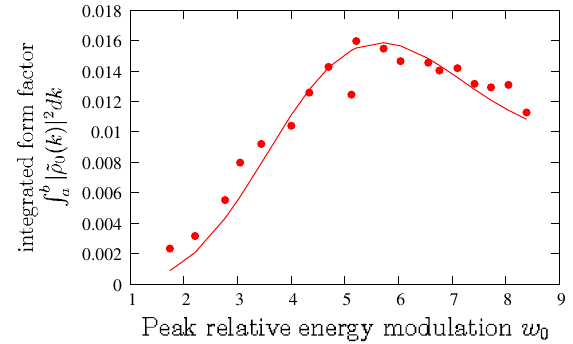
FIG. 6. Least square fit of Eq. (9) on experimental data. w 0 is the energy modulation in units of the initial energy spread. The vertical values are expected to be overestimated, as the laser beam has a smaller diameter than the electron bunch. Equal weights are attributed to every experimental